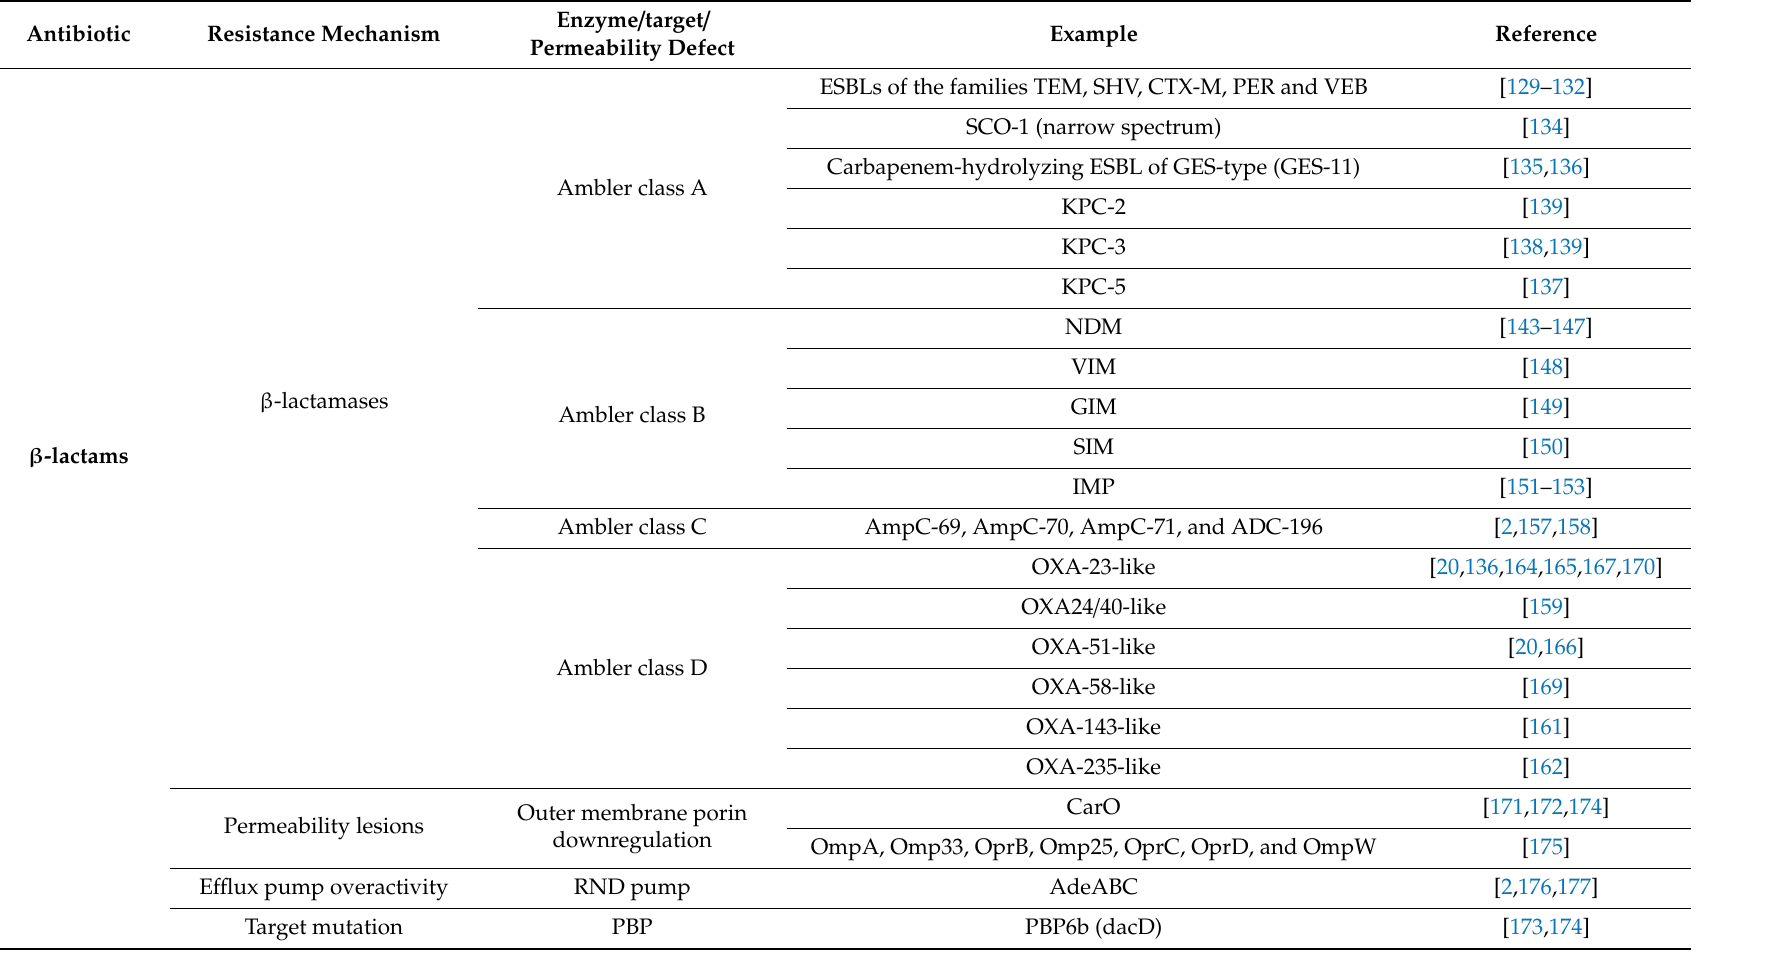
Table 1. Important resistance determinants in Acinetobacter baumannii showing possible enzymes / target modifications / permeability